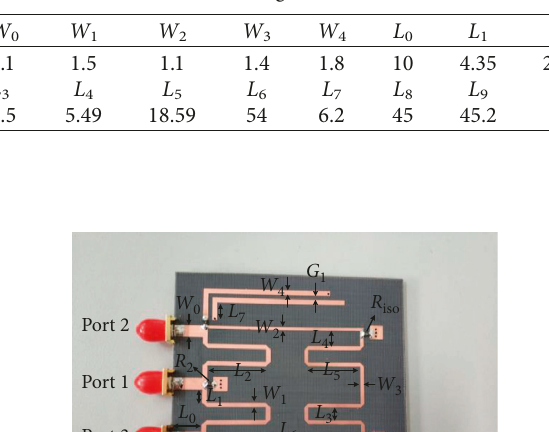
Table 1: Dimensions of power divider with single-stage RCSCL networks (unit: mm; refer to Figure 6).